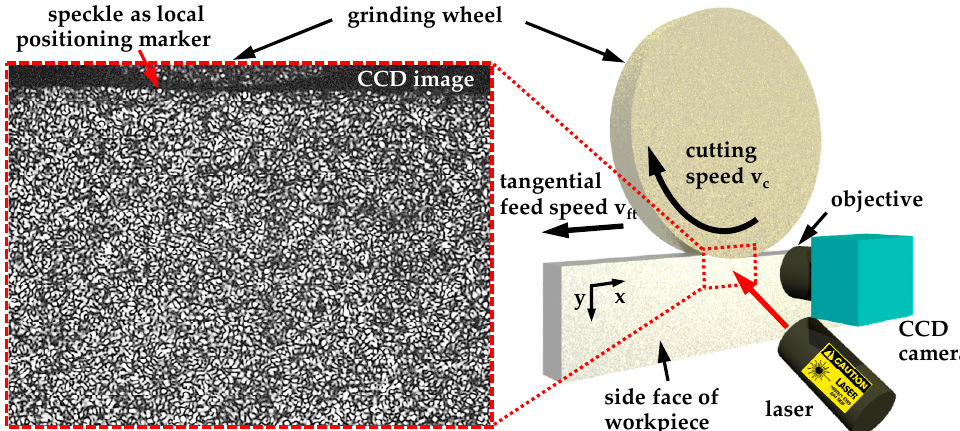
Figure 2. Measurement setup consisting of a laser and a CCD-camera and the captured image of the speckle pattern.